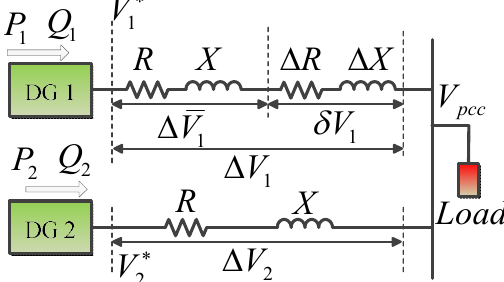
Figure 3. Structure of two DG units connected to a bus.